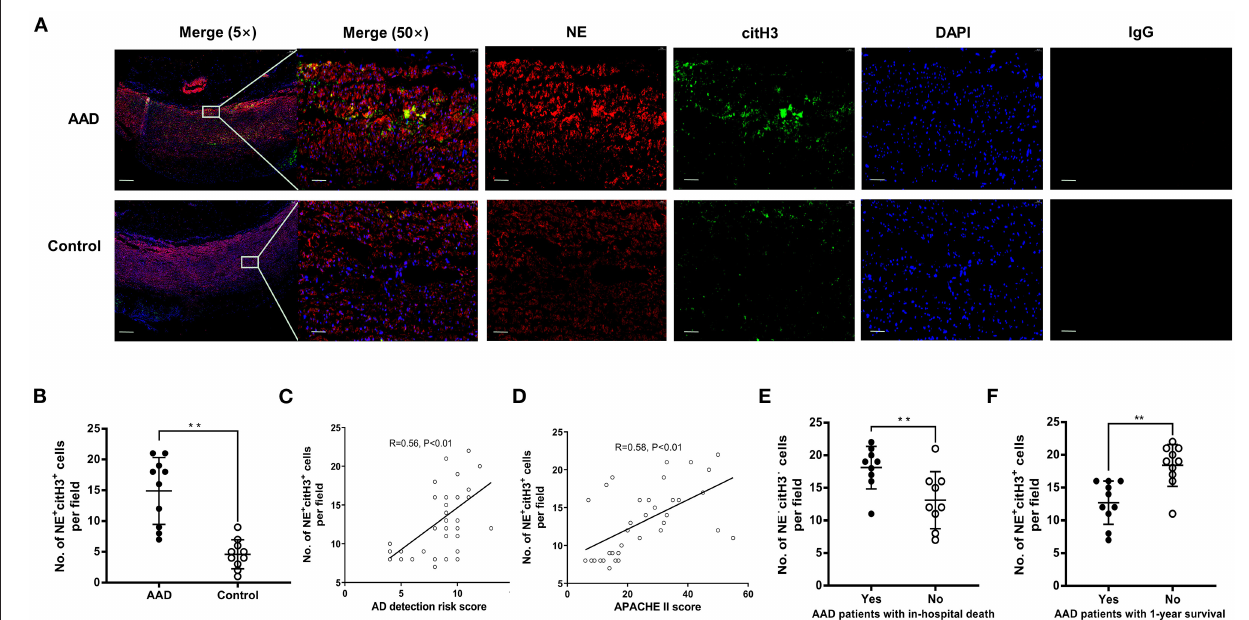
FIGURE 6 | The association between excess NETs in aortic tissue and disease severity or prognosis of patients with AAD. (A) Local NETosis was detected in aortic samples from AAD patients, as colocalization of NE with citH3 was observed by confocal microscopy. NE was stained green (Alexa Fluor 488) and citH3 was stained red (Alexa Fluor 647). DAPI staining was used to mark nucleus (blue fluorescence). (B) Compared with normal controls, the number of NETs formed per field in the tissue samples from AAD patients was significantly increased. (C,D) The number of NETs formed per field was positively correlated with the detection risk score of AD and the APACHE II score. (E) The number of NETs formed per field in patients with in-hospital death was significantly higher than that in patients without in-hospital death. (F) The number of NETs formed per field in patients with 1-year survival was significantly lower than that in patients without 1-year survival. ** P <